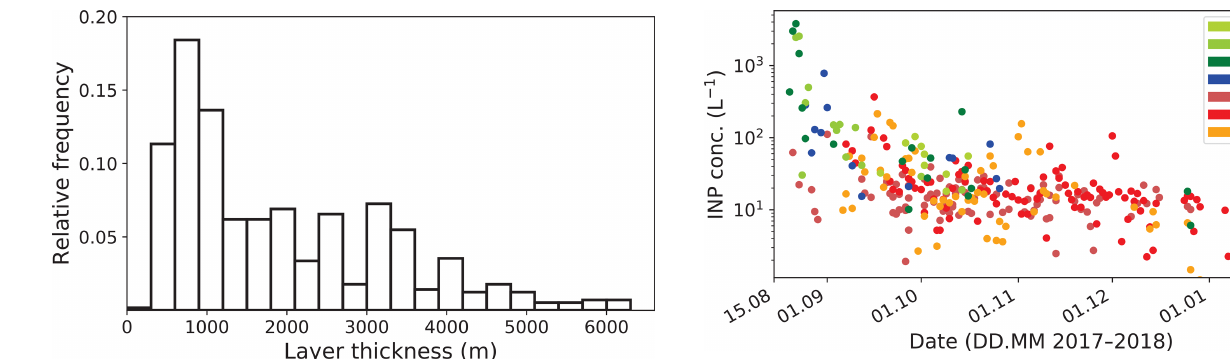
Figure 5. Frequency of occurrence of day-by-day smoke layer depth, considering all 566 detected layers, based on all Polly ob- servations at the seven sites from August 2017 to January 2018. neous period from October to December 2017, Kloss et al.